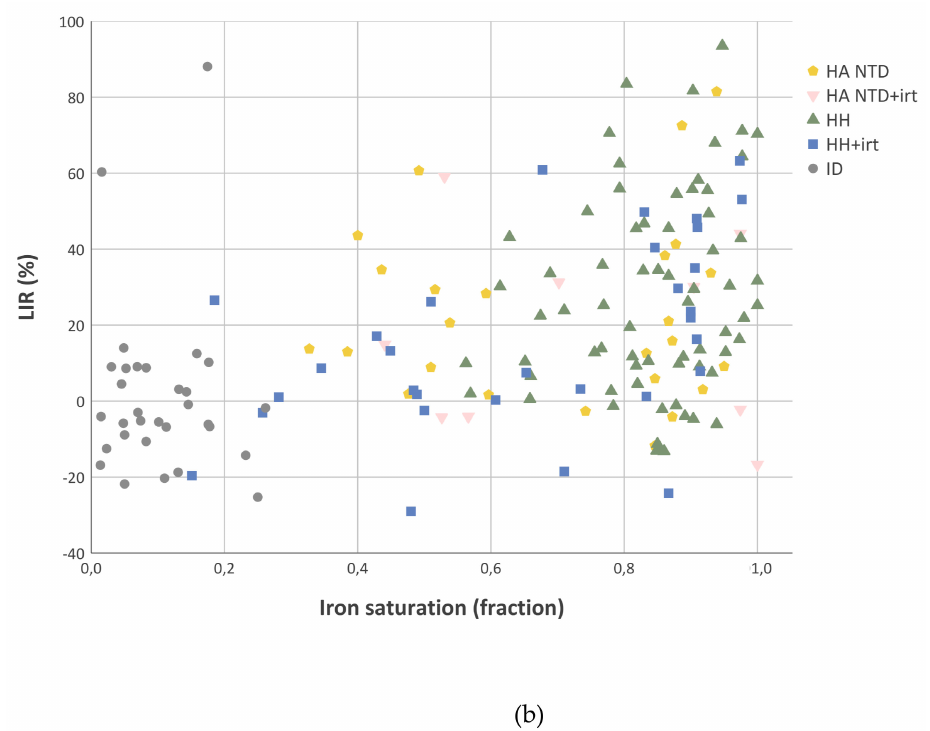
Figure 3. Liver iron retention (LIR). LIR calculated from the di ff erence between red blood cell iron utilization (RBCIU) after intravenous and oral iron test dose and expressed as percentage of intravenous RBCIU: LIR (%) = (RBCIU intravenous–RBCIU oral) / RBCIU intravenous × 100%. ( a ) Bar plot with mean LIR values. Error bars represent 95% confidence intervals. * p < 0.05 ( b ) Scatter plot with iron saturation (x-axis) and LIR (y-axis). Every dot represents a single analysis and is colored by diagnosis. HA NTD hereditary anemia non-transfusion dependent; HH hereditary hemochromatosis; ID iron deficiency; irt iron reducing therapy (phlebotomies or